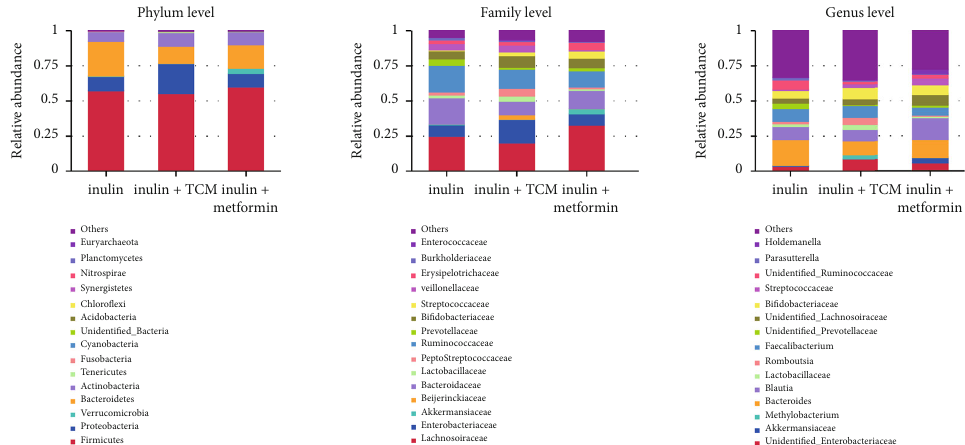
Figure 3: Relative abundance of bacterial taxa in the top 15 at phylum, family, and genus levels in patients with MetS treated with inulin, inulin+TCM, or inulin+metformin ( n = 20 each) for 6 months. MetS: metabolic syndrome; TCM: traditional Chinese